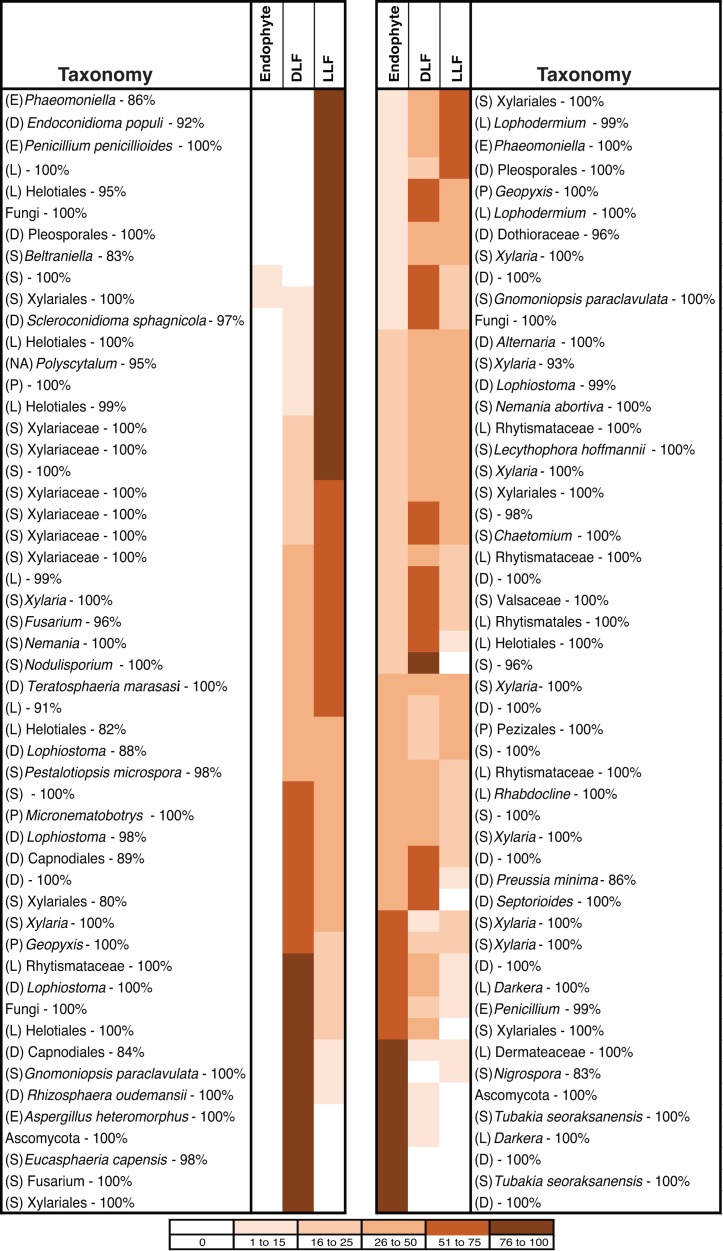
Heat map showing the distribution of 104 putative species (based on 95% rDNA sequence similarity; OTU with <5 isolates were excluded) of endophytic, dead leaf fungi (DLF), and leaf litter fungi (LLF) from plants in five North American sites.Species abundance on each leaf type is shown as the percentage of the total number of isolates of that species. Taxonomy was estimated for each species using the Ribosomal Database Project naïve Bayesian classifier with the UNITE ITS database. The lowest level of taxonomy supported by ≥80% confidence is shown (classes are abbreviated as Sordariomycetes (S), Leotiomycetes (L), Eurotiomycetes (E), Dothideomycetes (D), Pezizomycetes (P), or not available (NA)). Statistical support for each assignment is given after the dash. Taxa are ordered according to their abundance as endophytes or LLF.